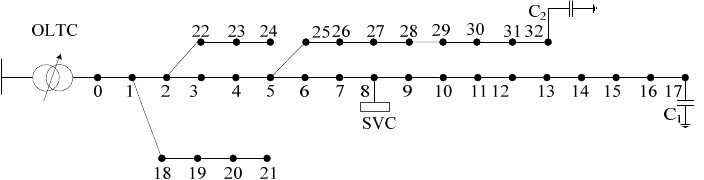
Figure 6. Topology of modified IEEE 33-bus radial distribution network.